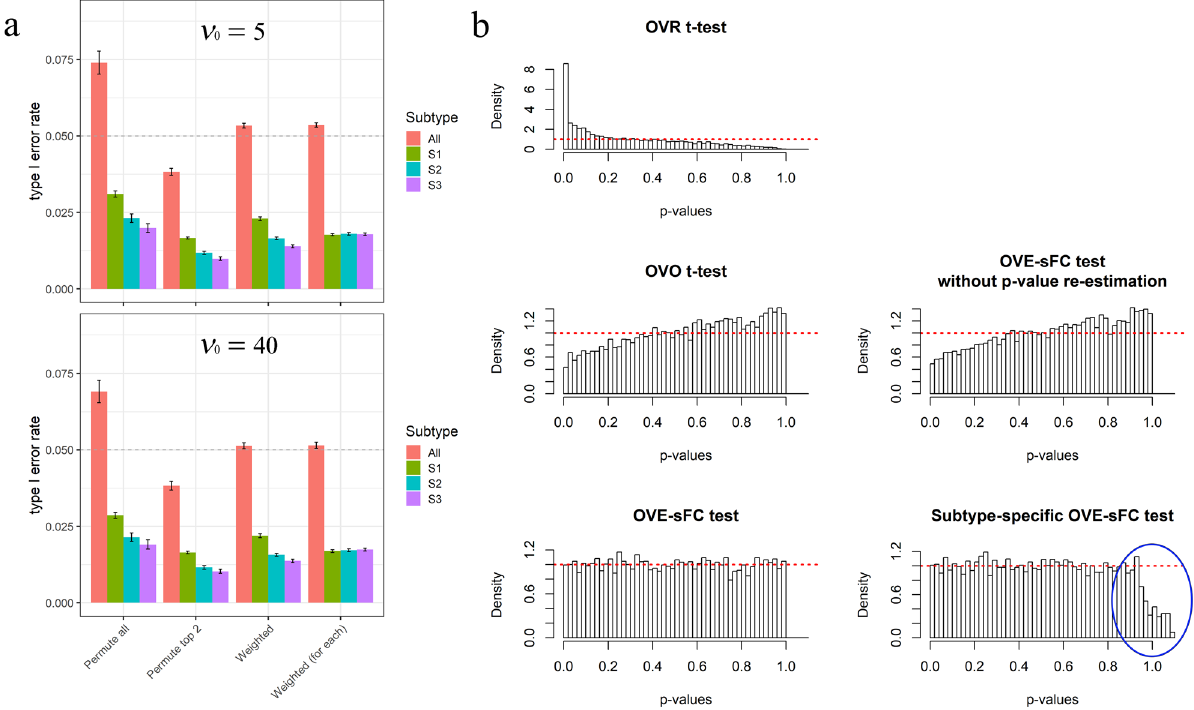
Figure 2. Assessment on Type 1 error rates and p value distributions using simulated data sets under the null hypothesis, involving three subtypes with unbalanced sample sizes . 10,000 non-SDEGs are simulated with a portion of housekeeping genes taking the baseline expression levels across all the three subtypes. The remaining non-SDEGs are adjusted to exhibiting similar upregulations in two subtypes. The sample size per subtype is 3, 6, and 9. ( a ) Bar chart for the mean and 95% confidence interval of type I error rates with p value cutoff at 0.05 over 150 simulation-based experiments, showing both overall and subtype-specific false-positive rates corresponding to different permutation schemes. 30 parameter settings, with 5 replicates for each, adopted varying housekeeping gene percentages (95%, 80%, 60%, 40%, or 25%), different prior degrees of freedom ν 0 (5 or 40), and σ 0 values (0.2, 0.5, or 0.8). ( b ) Histograms of p value distributions associated with the five